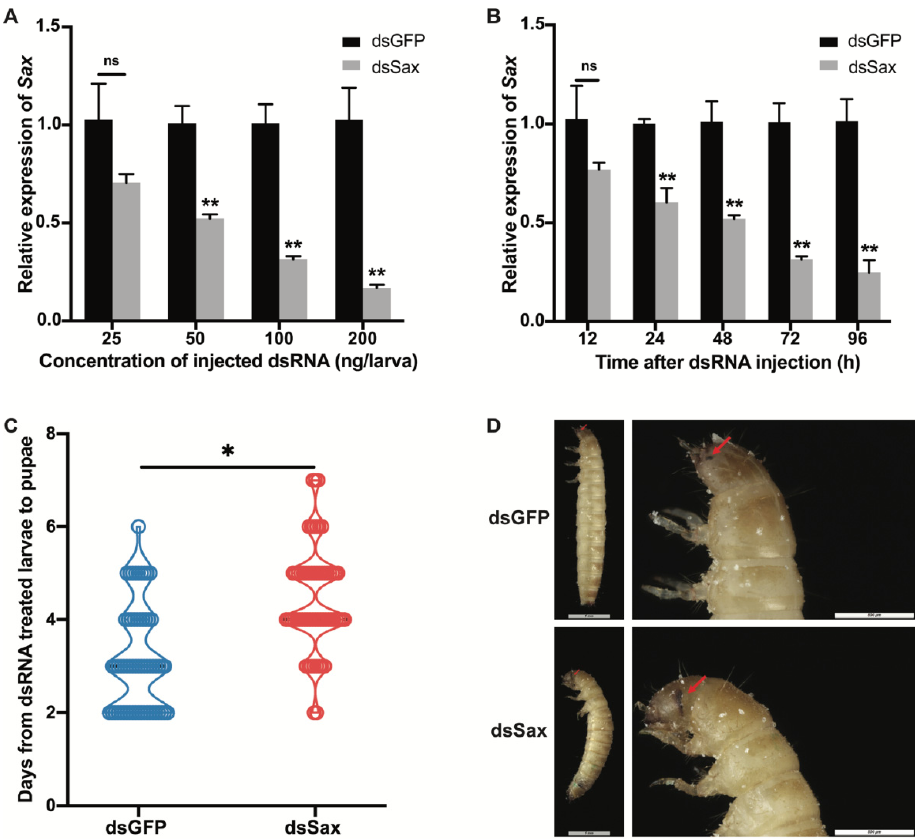
Figure 4. The efficiency of Sax RNAi and its effect on larval-pupal development. ( A ) Relative expression levels of Sax 72 h after different doses of dsSax injection. ( B ) Relative expression levels of Sax 12–96 h post 100 ng/larva of dsSax injection. ( C ) Days from dsRNA treated 19-day larvae to newly formed pupae from the dsGFP and dsSax-treated groups (100 ng/larva). ( D ) Phenotype of larva in the dsGFP (100 ng/larva)-treated groups and larva arrested during the quiescent stage in the dsSax (100 ng/larva)-treated groups. The red arrows indicated the normal eye and abnormal eye development in the Sax RNAi larva. NS indicated non-significant differences between the treatment and corresponding control, p > 0.05 by t -test, asterisks above bars indicate significant differences between the treatment and the control, * p < 0.05, ** p < 0.01 by t -test.